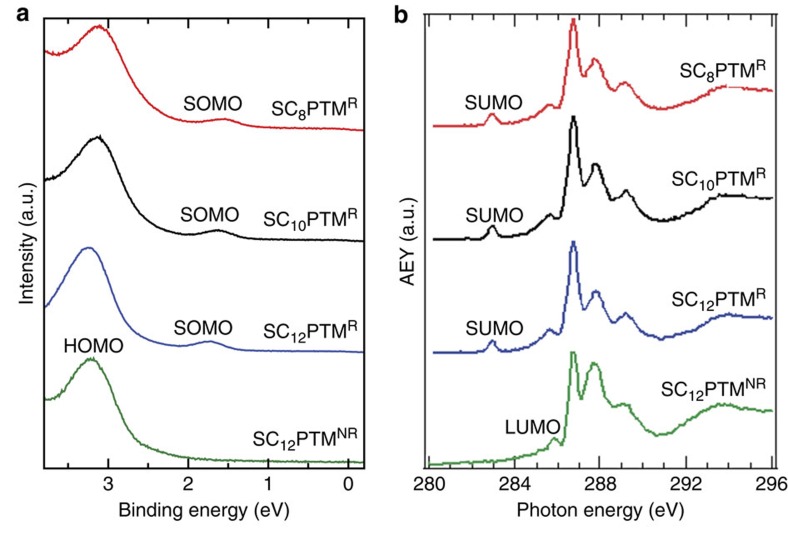
Electronic structure of the PTMR/NR SAMs on AuTS.(a) Ultraviolet photoemission spectroscopy (UPS) and (b) C K-edge X-ray absorption fine structure (NEXAFS) spectra of SAMs derived from HSCnPTMR with n=8, 10, 12 and HSC12PTMNR.